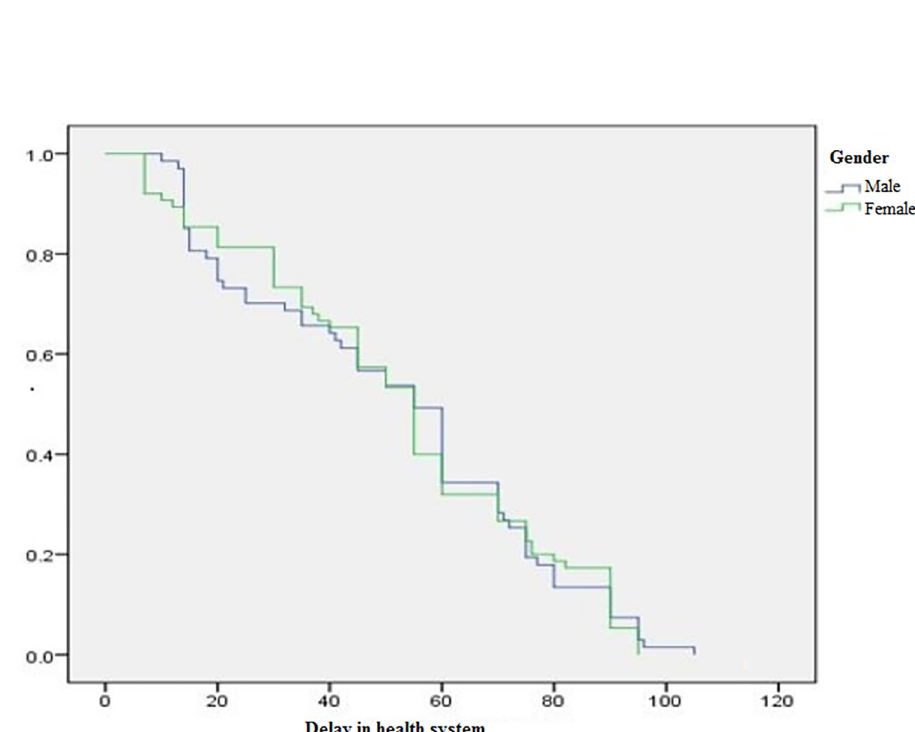
Fig 2. Kaplan–Meier curve of health system delays by gender of study participants.